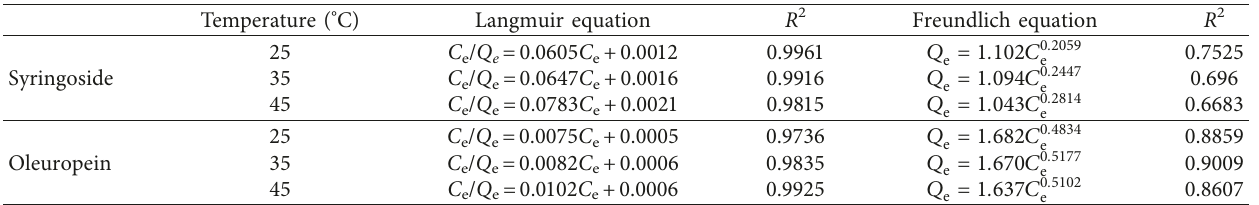
Figure 5: Adsorption isotherms (a, d), fitting result by the Langmuir equation (b, e), and Freundlich equation (c, f) for syringoside and oleuropein, respectively, on the HPD-100B resin at 25, 35, and 45 ° C. Table 2: Langmuir and Freundlich adsorption equations of syringoside and oleuropein on the HPD-100B resin at different temperatures.